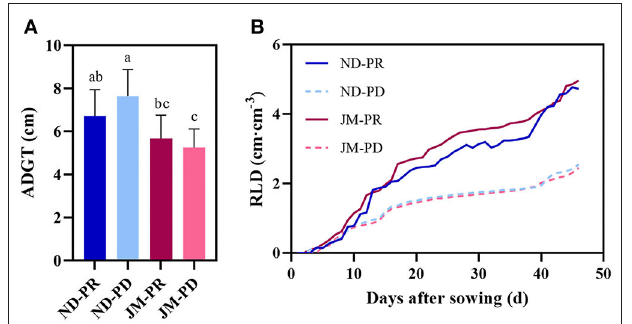
FIGURE 5 | Difference in average daily growth of taproots (ADGT) (A) and lateral root branching density per unit volume (RLD) (B) of two cotton cultivars under different phosphorus levels. ND-PR, “Nongdamian No. 10” cultivar under replete phosphorus conditions; ND-PD, “Nongdamian No. 10” cultivar under low phosphorus; JM-PR, “Jimian 315” cultivar under replete phosphorus conditions; JM-PD, “Jimian 315” cultivar under low phosphorus. Depicted are the means of six replicates ± standard errors. For each trait, bars with the same letter are not significantly different according to Duncan’s test at a P < 0.05 threshold.